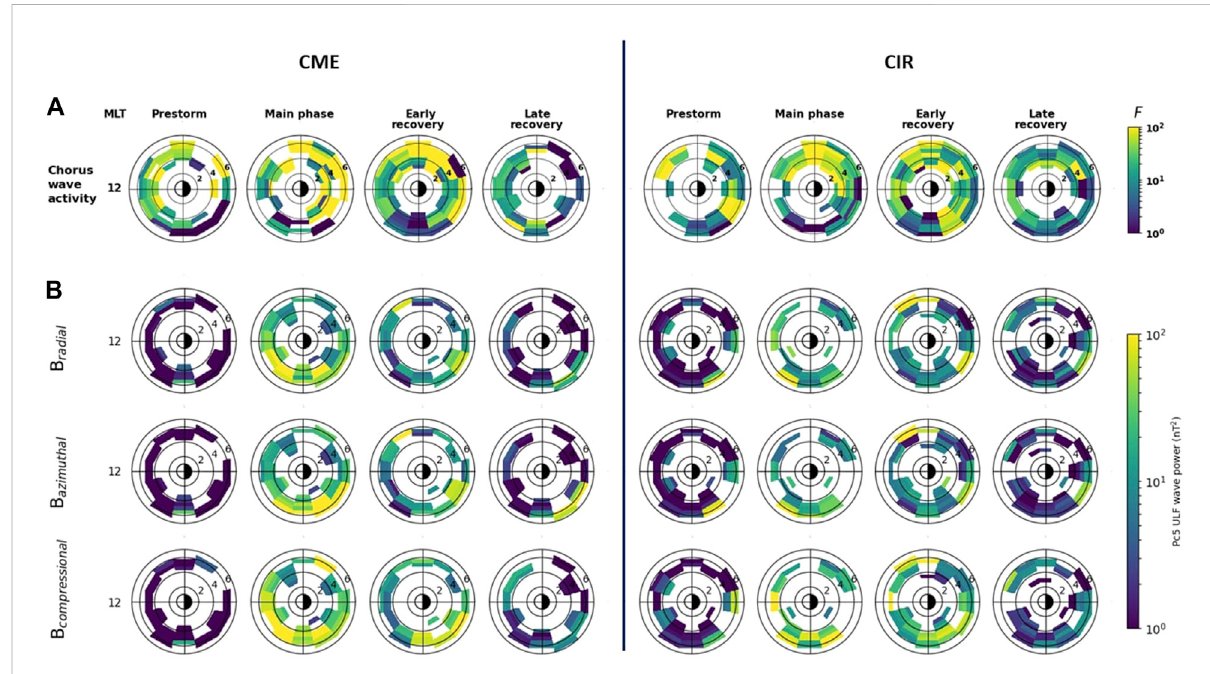
FIGURE 5 (A) L-MLT distribution of average integrated chorus wave excitation factor F during the four storm phases for coronal mass ejection (CME; left panels) and corotating interacting region (CIR; right panels) driven geomagnetic storms in the same manner as in Figures 2 – 4. The colorbar shows the excitation factor F in logarithmic scale (B) L-MLT distribution of ULF waves covering the Pc5 frequency range (2 – 7 mHz) for the three magnetic fi eld components (radial, azimuthal and compressional) during the four phases of geomagnetic storms driven by CMEs (left panel) and CIRs (right panel). The colorbar at the right represents Pc5 ULF wave